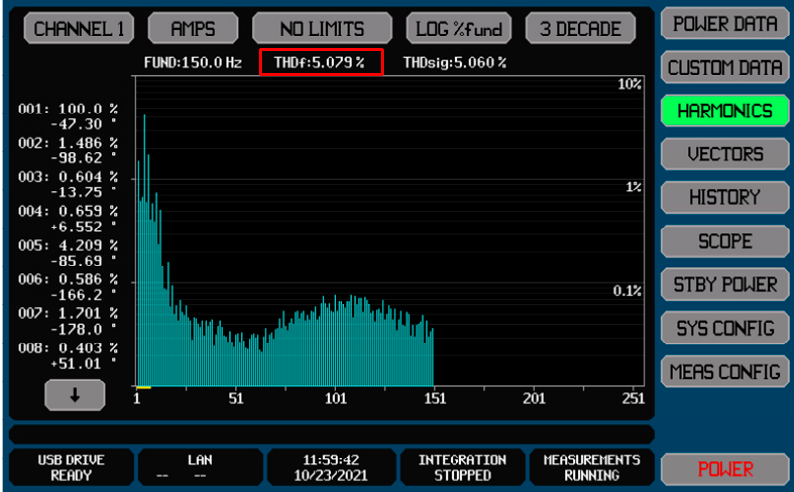
Figure 27. Output current THD i of the drive developed at rotational speed frequency command of 150 Hz.